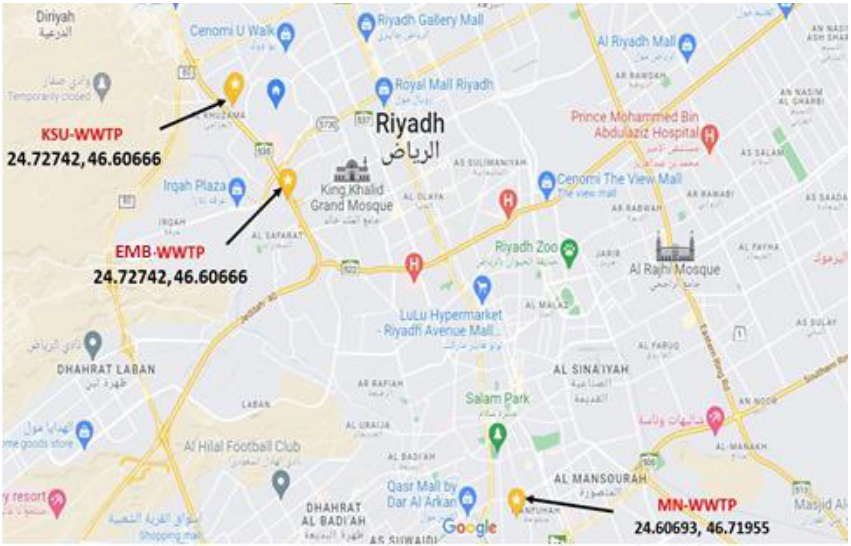
Figure 1. Latitude and longitude of sampling locations in Riyadh, Saudi Arabia.